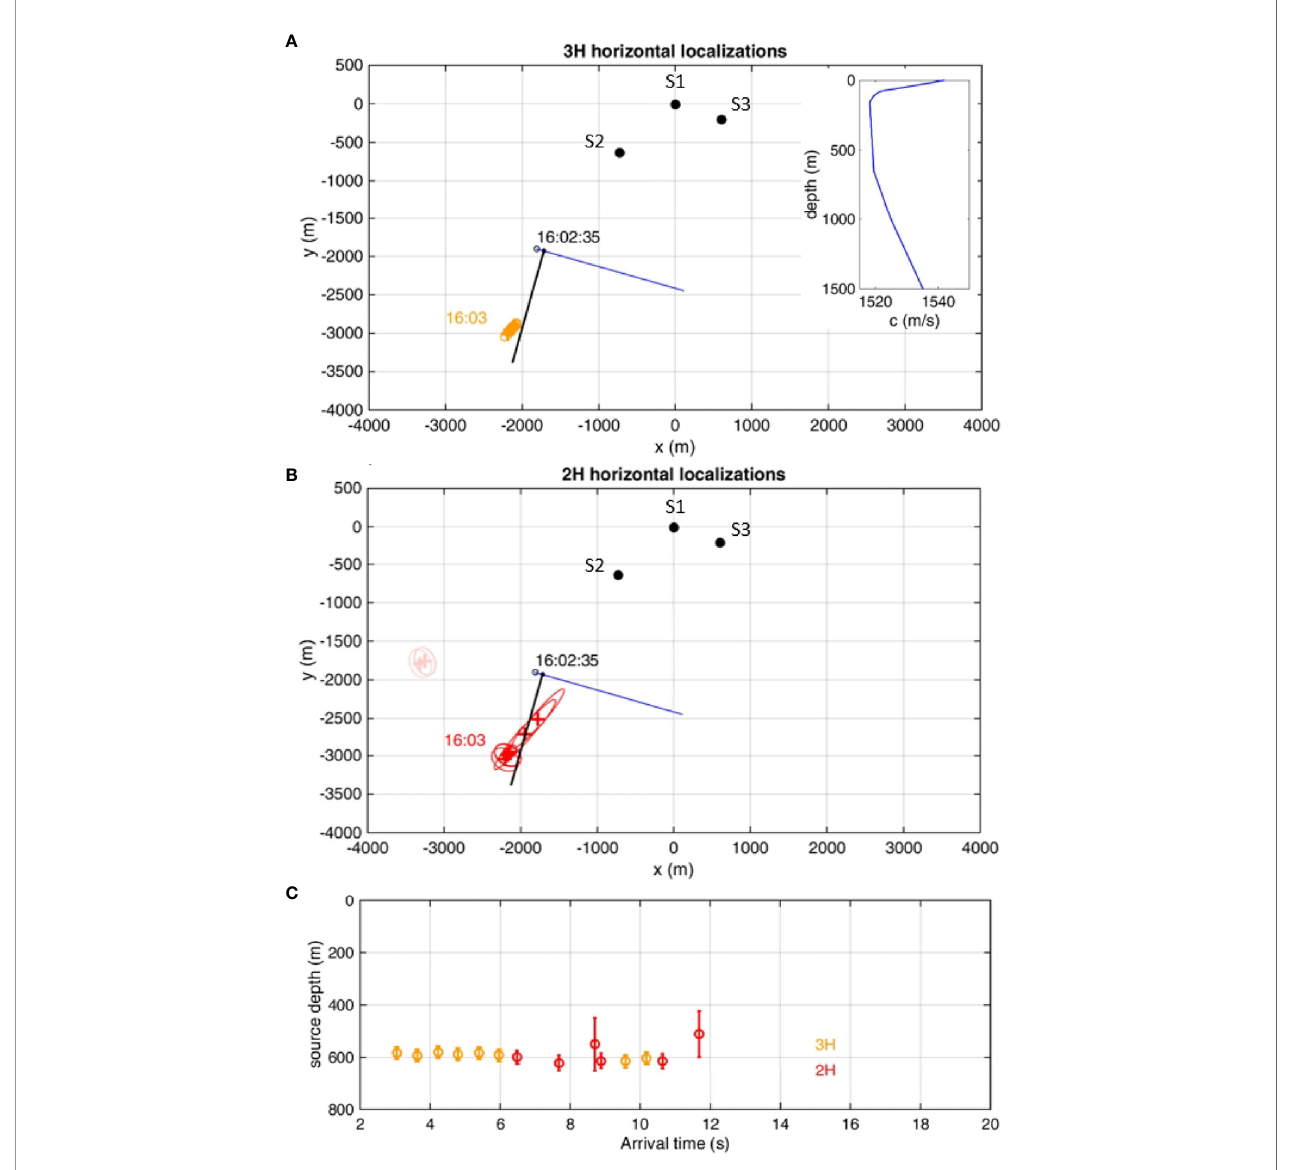
FIGURE 10 | (A, B) Localization results (in orange/red) on 16 July 2021 at 16:03 in the horizontal and (C) in the vertical based on receptions at three (3H) or two (2H) hydrophones. The symmetric solutions from 2H localization in the horizontal are also shown (light red) in (B) . The embedded graph in (A) shows the sound- speed pro fi le measured in mid July. The blue line and the open circle in (A, B) show the vessel course and position, respectively, at 16:02:35; the black line shows the broadside direction of the towed array of